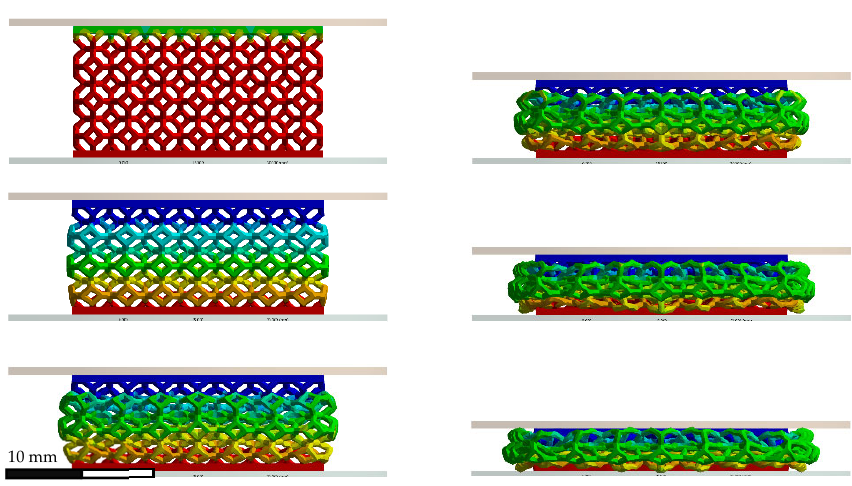
Figure 8. Quasi ‐ static compression sequence for non ‐ graded lattice. Figure 8. Quasi-static compression sequence for non-graded lattice.